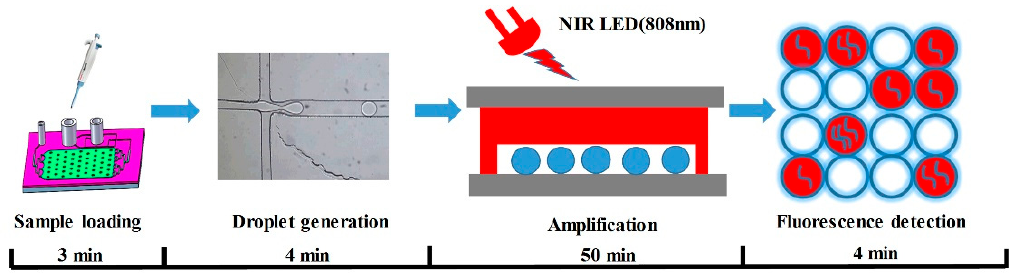
Figure 8. The operation process of digital LAMP assay.